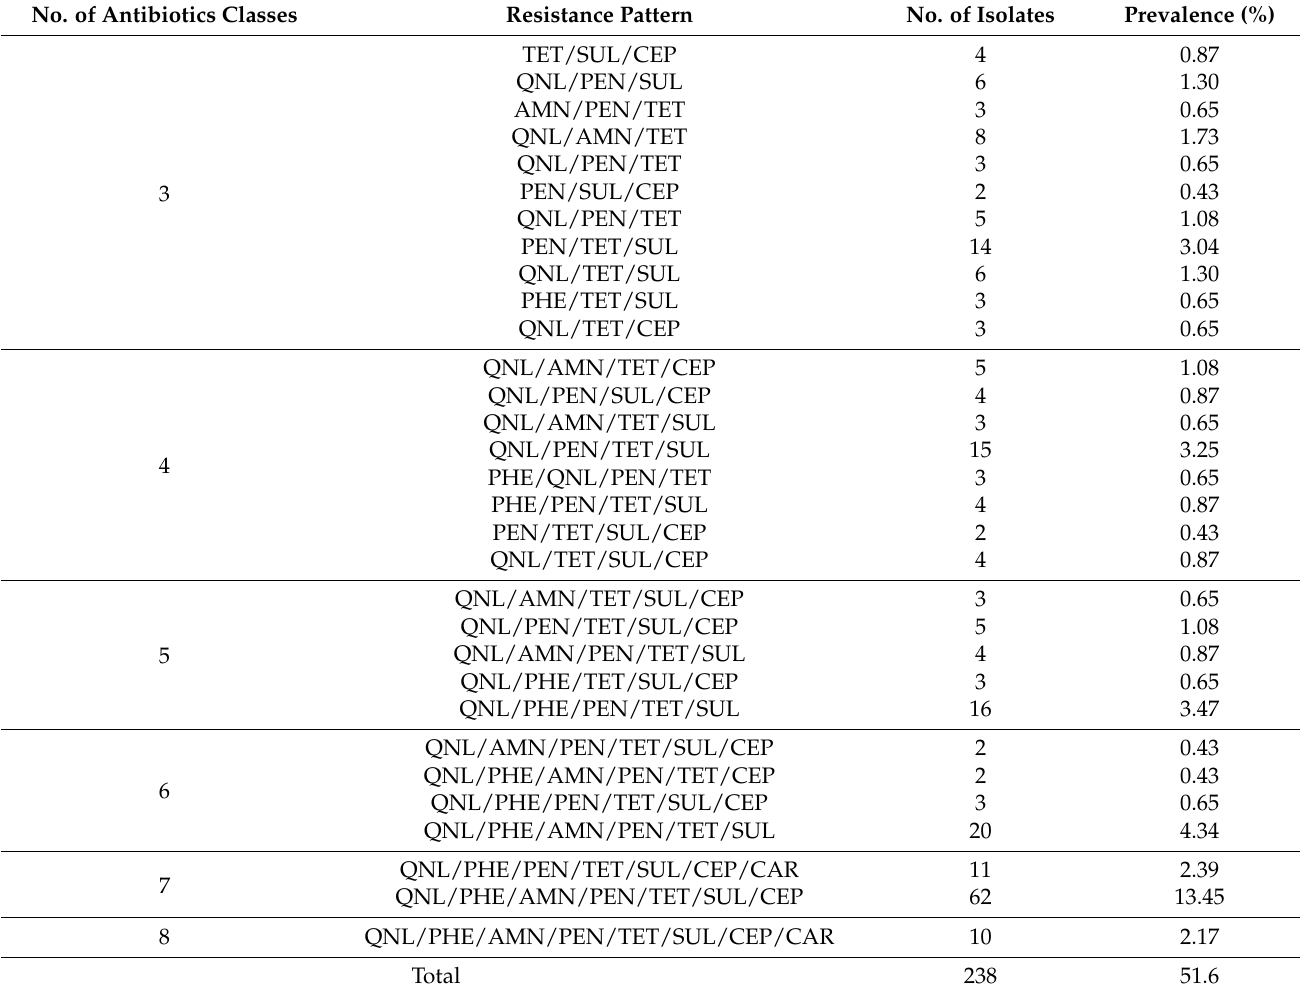
Table 5. Multidrug resistance patterns among 431 E. coli isolated from poultry and domestic pigs.